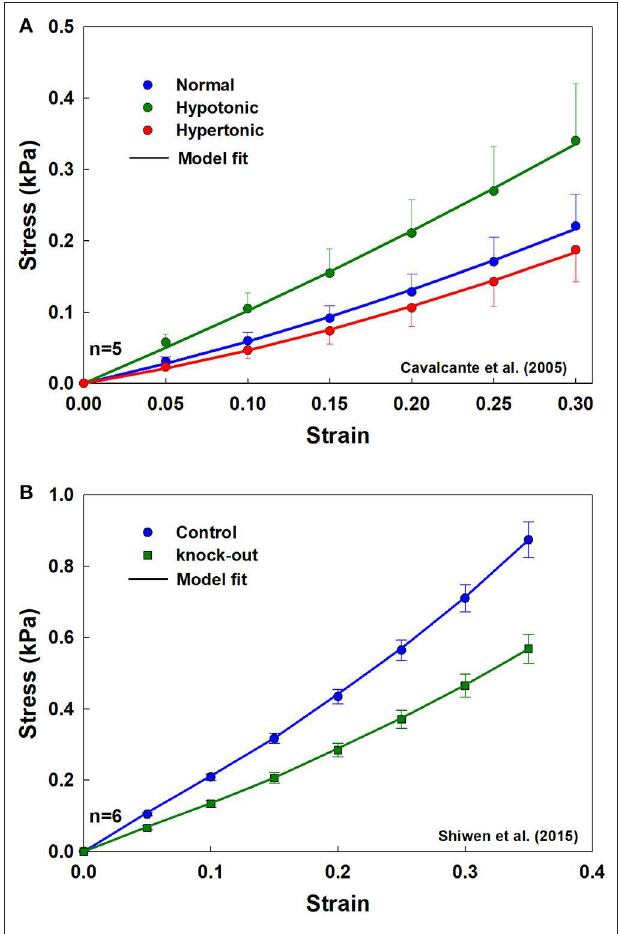
FIGURE 6 | Population mean and standard error, with model fits (solid lines) for the tissue strips for (A) three different tonicities (normal, hypertonic, and hypotonic) from rat lungs, and (B) from WT and MRTF-A KO mice.